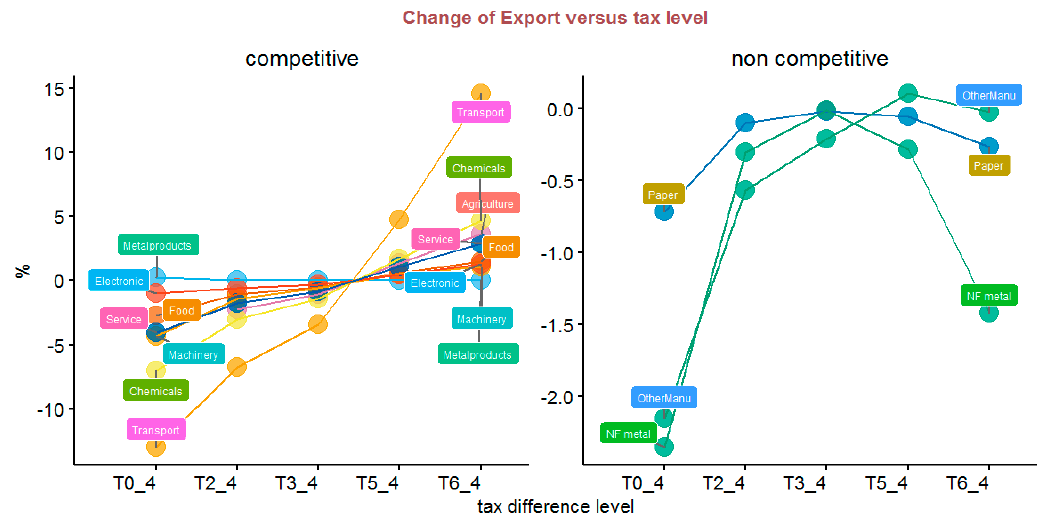
Figure 6. Export change compared with T4_4 of Guangdong Province in 2030.